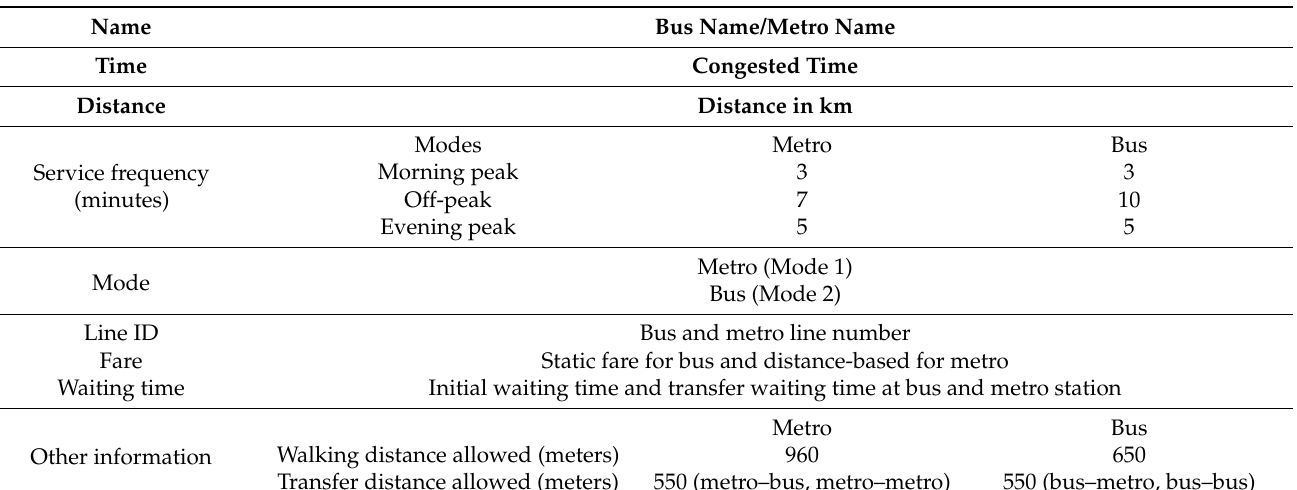
Table 2. Transit network attributes.